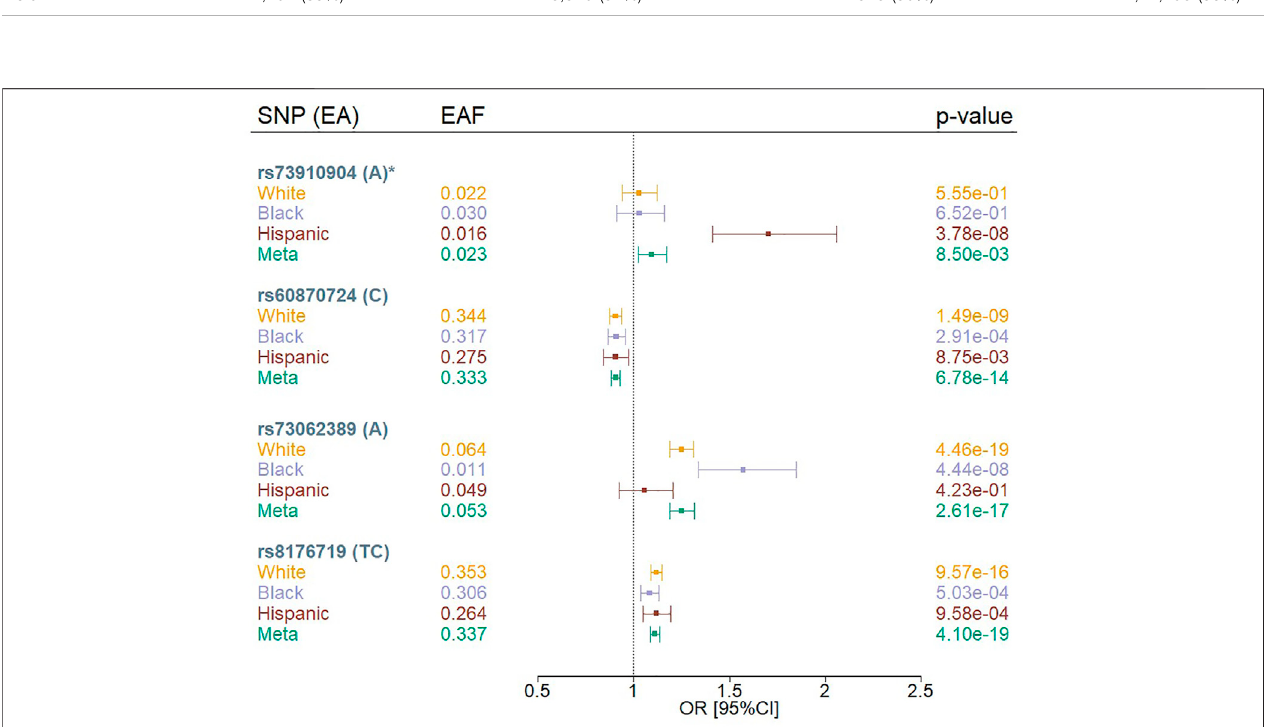
FIGURE 1 | Forest plots of SNPs associated with COVID-19 positivity (POS vs . POP) in MVP by population. EA (cid:1) effect allele, EAF (cid:1) effect allele frequency, OR (cid:1) odds ratio; Meta (cid:1) Multi-population meta-analysis * indicates that the SNP association was novel.